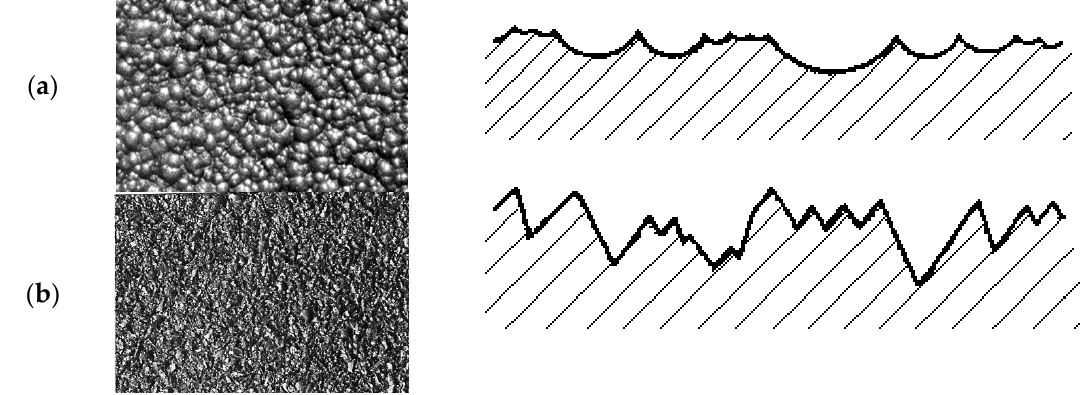
Figure 2. The surface of metallic substrate blasted by polydispersed ( a ) shot ( b ) grit.